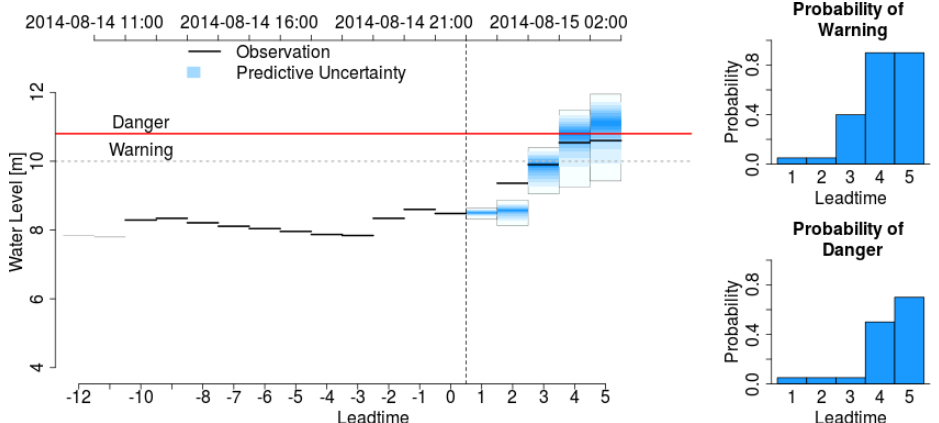
Figure 6. Flood4T enhanced probabilistic flood forecast issued at 23:00 (local time) 14 August 2014. Panel (a) shows predictions of future water level (blue) for the next 5h (observed levels at each time are shown in black). Panels (b) and (c) show the probability of crossing the respective warning levels in the next 5h. Source: Smith et al.